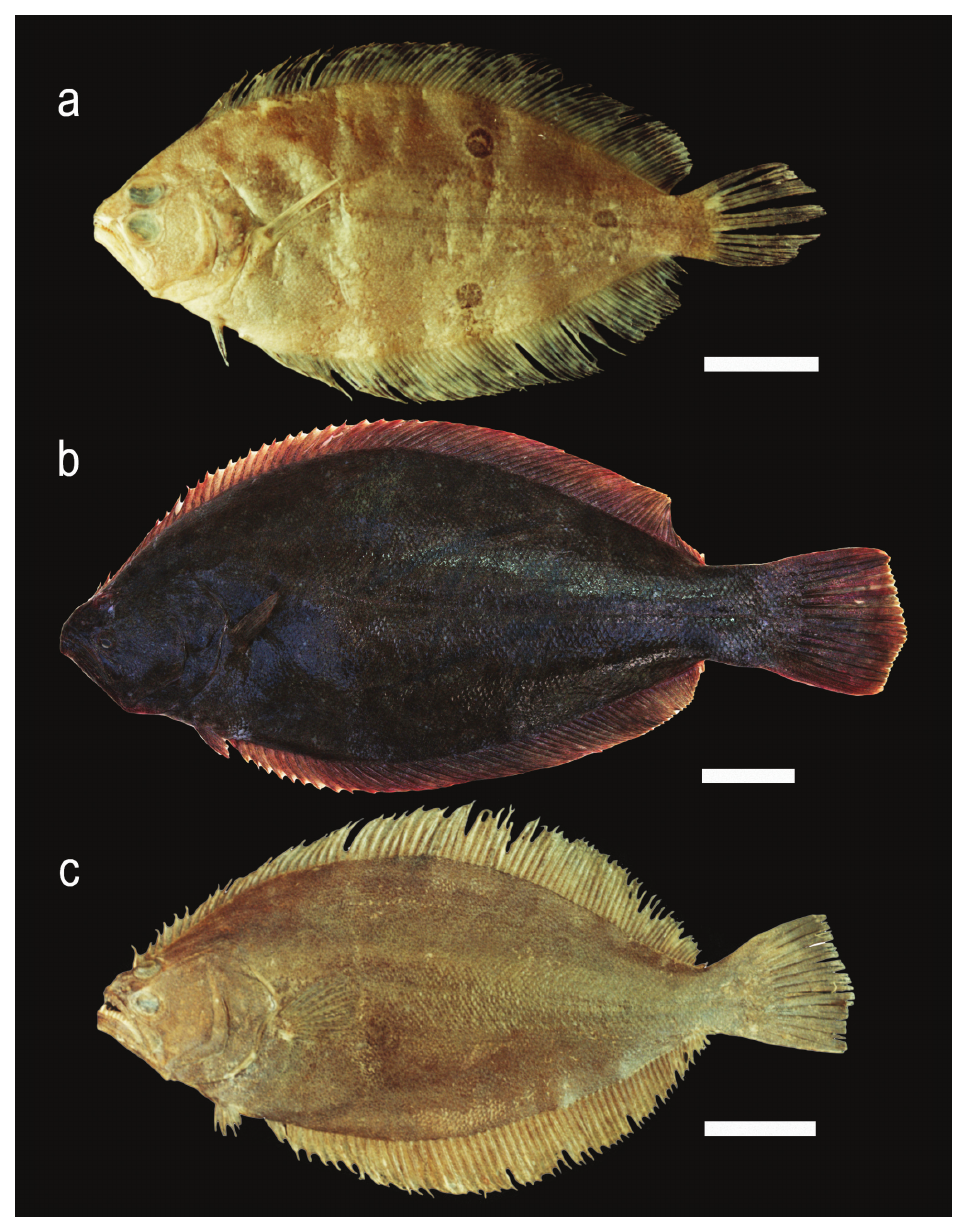
Fig. 1. Photographs of three flatfishes of Paralichthys from the Southwestern Atlantic: a. Paralichthys isosceles , b. Paralichthys orbignyanus , c. Paralichthys patagonicus . Scale bar indicates 5